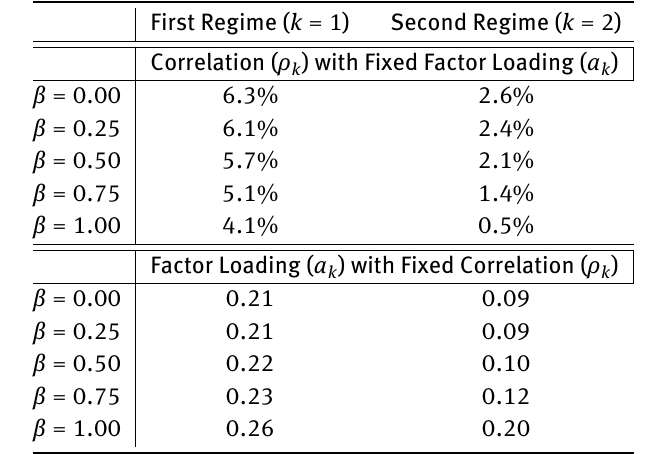
Table 4.1: The upper half of this table illustrates the impact of state dependence on correlations when factor loadings are held fixed, in the context of our numerical example. Recall that factor loadings are ( a 1 , a 2 ) = (0.25, 0.16) , regime probabilities are ( p 1 , p 2 ) = (0.85, 0.15) and the marginal default probability is q = 0.037 . For each of the indicated values of β , we compute σ k using (4.9) and then compute ρ k using (4.10) , all other parameter values are held fixed. The lower half of the table illustrates the factor loading required to maintain correlations of ( ρ 1 , ρ 2 ) = (0.044, 0.008) as we vary the degree of state